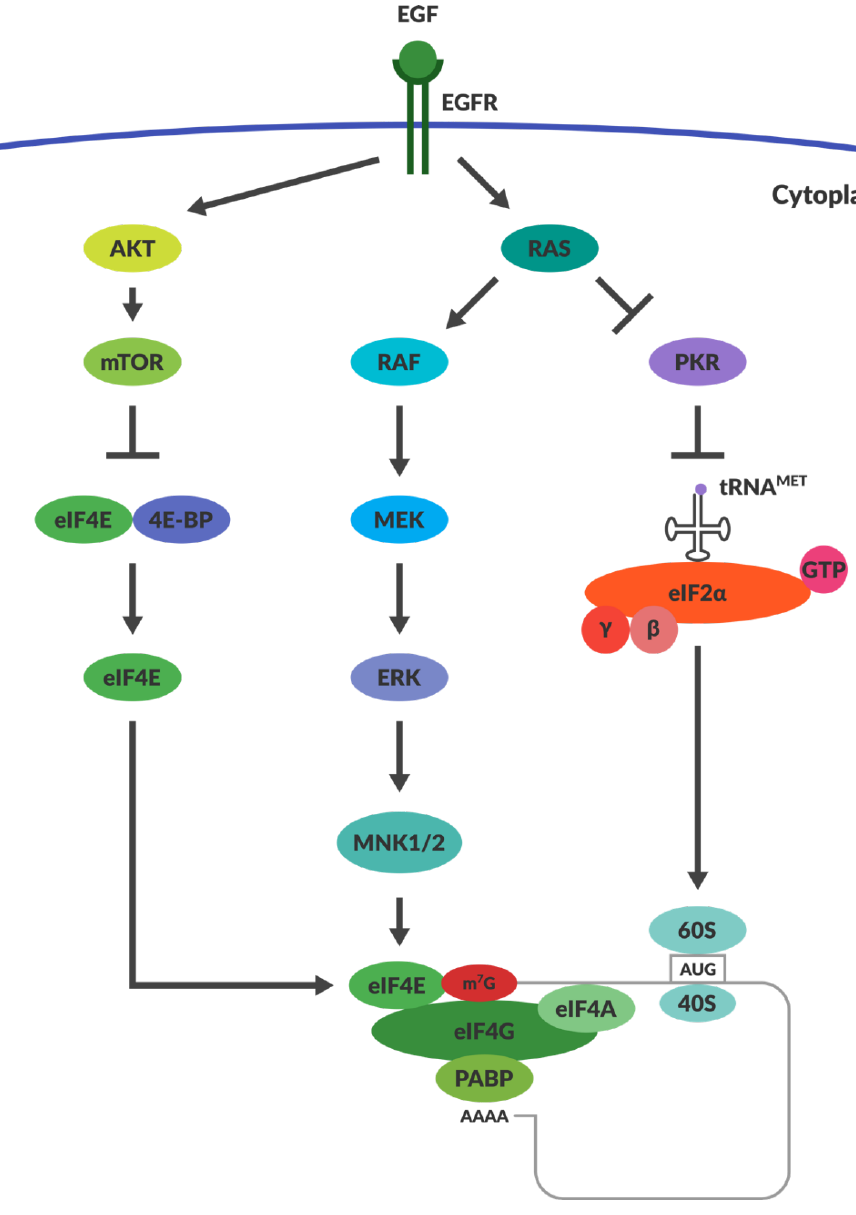
Figure 2. Regulation of Translation within Cancers. The mechanisms responsible for translational regulation are illustrated in the diagram. Overexpression of RAS drives inhibition of PKR, thereby allowing the function of eIF2 α . RAS activation stimulates the activation of MNK1/2, which facilitates eIF4E function. AKT overexpression prevents the function of inhibitor 4E-BP. This allows eIF4E to function as a cap binding protein within the ternary complex formed during translation.